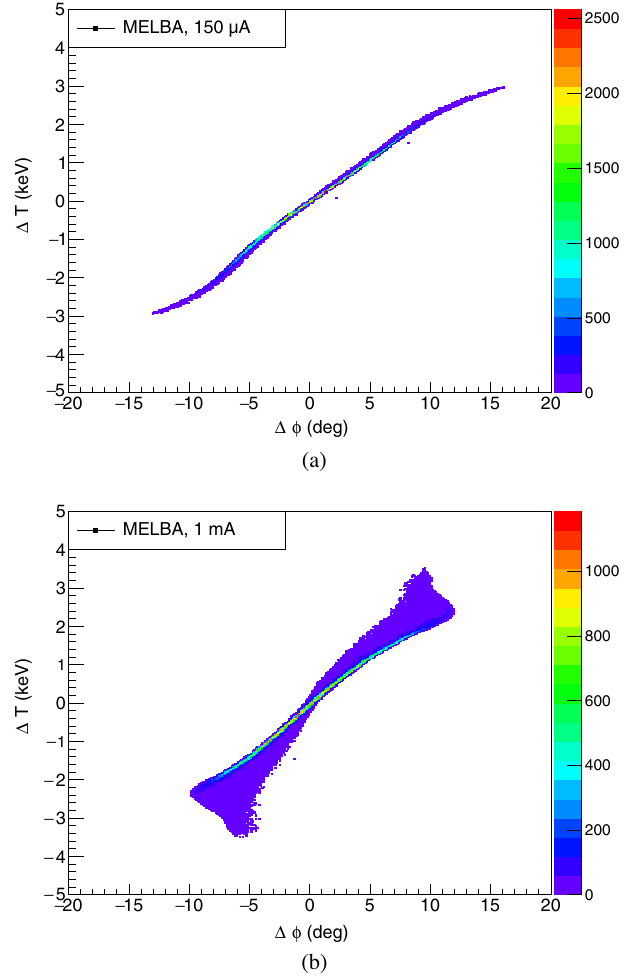
FIG. 2. Particle distributions in longitudinal phase space of different beam currents (Fig. 2a: I ¼ 1 mA) at the end of MELBA that are injected into the first I b MAMBO rf